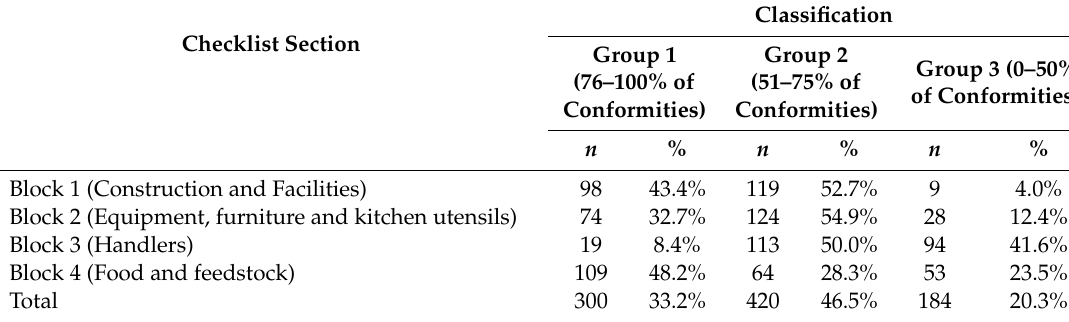
Table 3. Classification of the home kitchens in groups according to conformities to the instrument in the Federal District, Brazil,